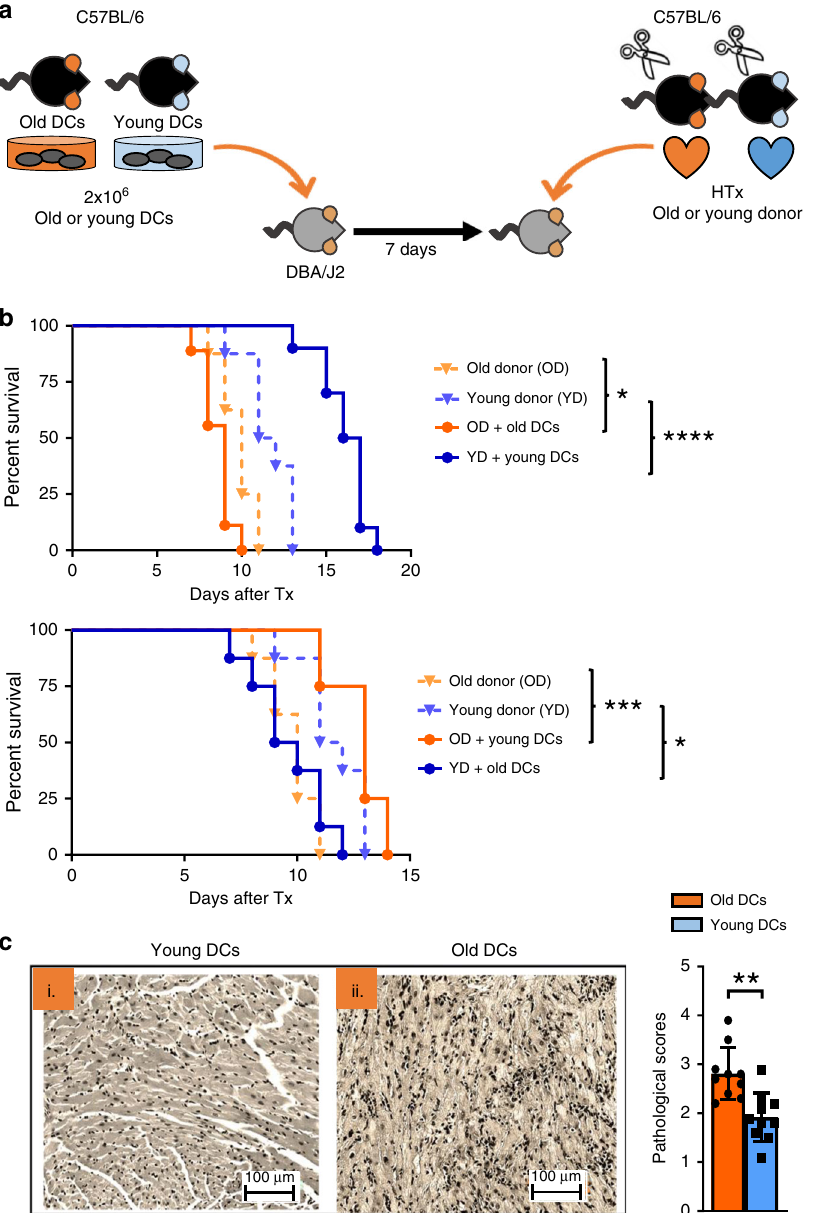
Fig. 2 Dendritic cells from old mice impair cardiac allograft survival in young DBA/2J mice. a 2 × 10 6 CD11b + CD11c + DCs were sorted from old and young C57BL/6 mice and administered i.v. into young DBA/2J mice 7 days prior to allogeneic cardiac transplants. b Kaplan – Meier analysis of cardiac allografts from old and young C57BL/6 mice transplanted into untreated DBA/2J recipients compared with those that had received adoptively transferred CD11b + CD11c + DCs from old and young B6 mice (old donor vs. old donor + old DCs ( p = 0.0216)/ + young DCs ( p = 0.0005) and young donor vs. young donor + young DCs ( p < 0.0001)/ + old DCs (0.0182); ( n = 8 biologically independent animals). c By day 11 after transplantation, grafts were procured, perfused, and 5 mm sections were stained with H&E for pathological evaluation ( p = 0.0011); n = 10/group, results are representative of at least three independent experiments. Column plots display mean with standard of the mean (SEM). Statistical signi fi cance for survival data was determined by log- rank Mantel – Cox test while pathological scores were compared by two-tailed Mann – Whitney-test. Asterisks indicate p values * p ≤ 0.05, ** p ≤ 0.01, and *** p ≤ 0.001, only signi fi cant values are shown. Source data are provided as a Source Data fi